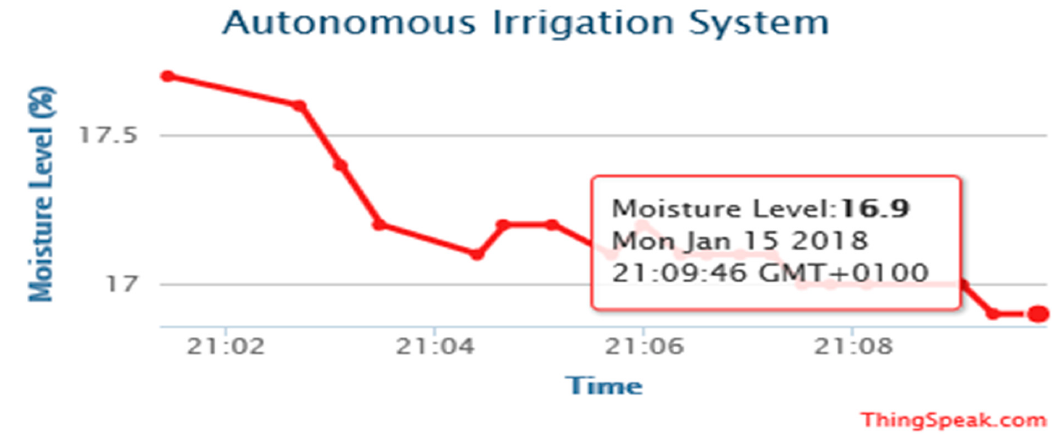
Figure 15. Moisture levels against time obtained from http://www.thingspeak.com (API key = FE4H530DNA2NJQXB).